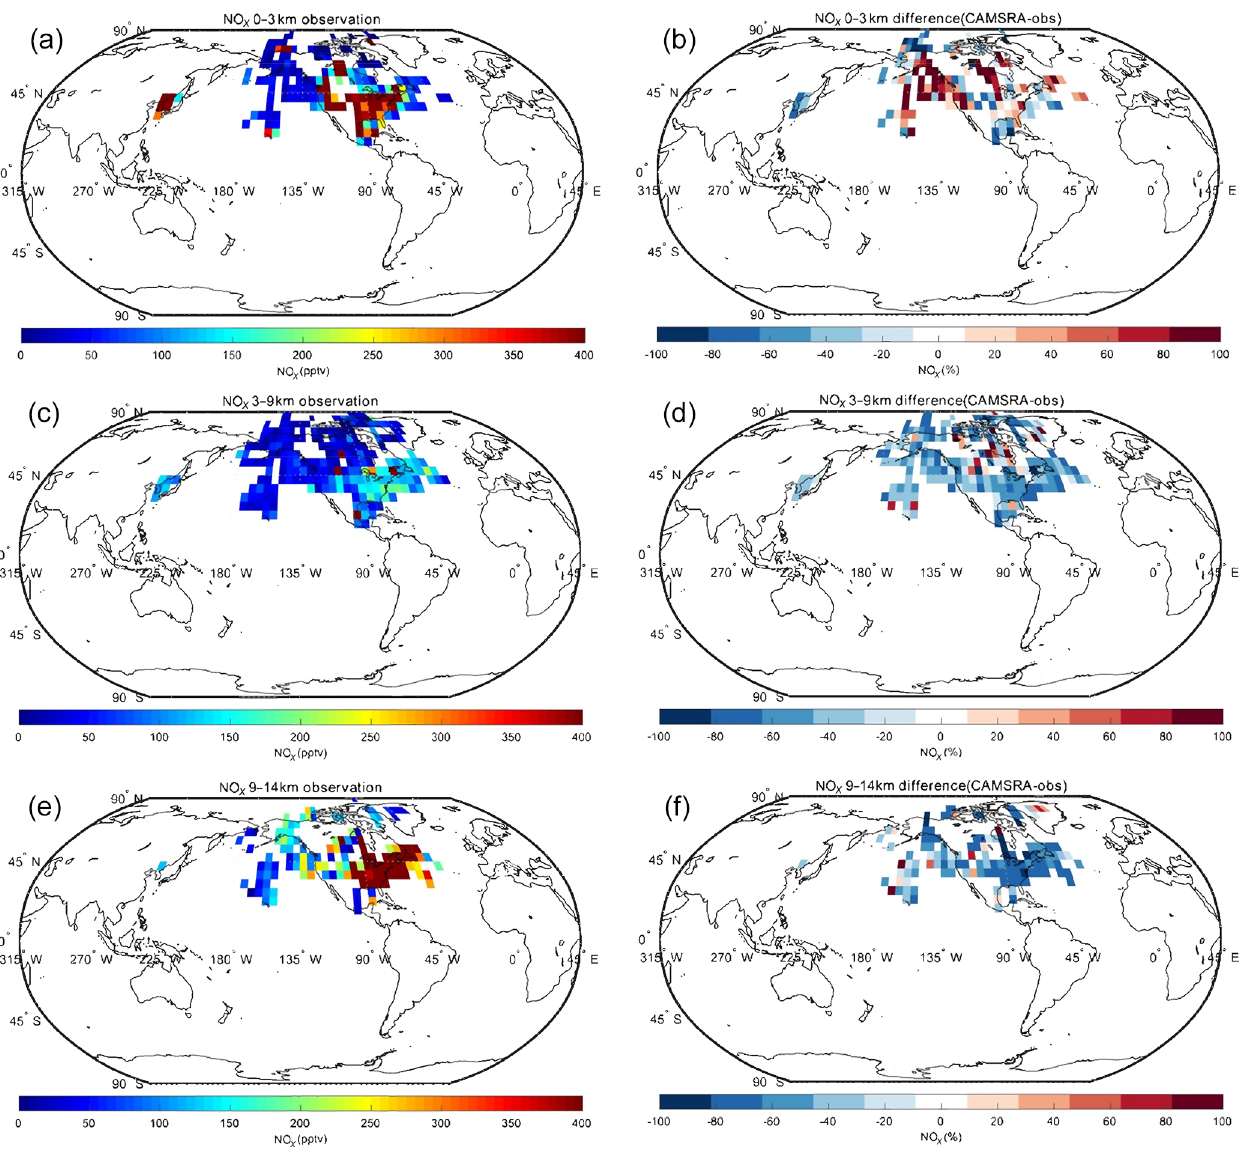
Figure A1. Campaign observations of NO x (a, c, e) and the difference between the CAMSRA and the observations (CAMSRA – observation; b , d , f ). The data are averaged to 5 ◦ × 5 ◦ (latitude × longitude) and to three altitude bins: 0–3, 3–9 and